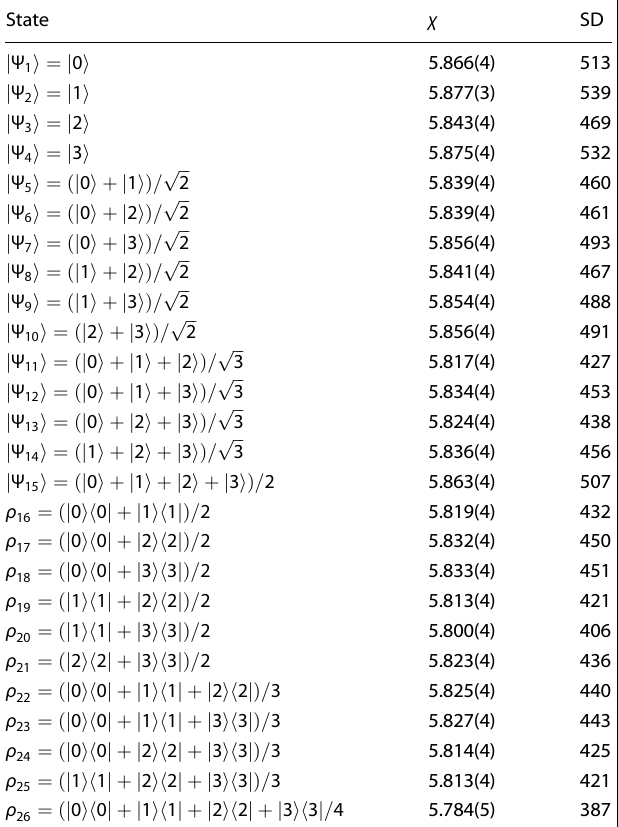
Table 1. Experimental results of χ for 26 different states being tested.